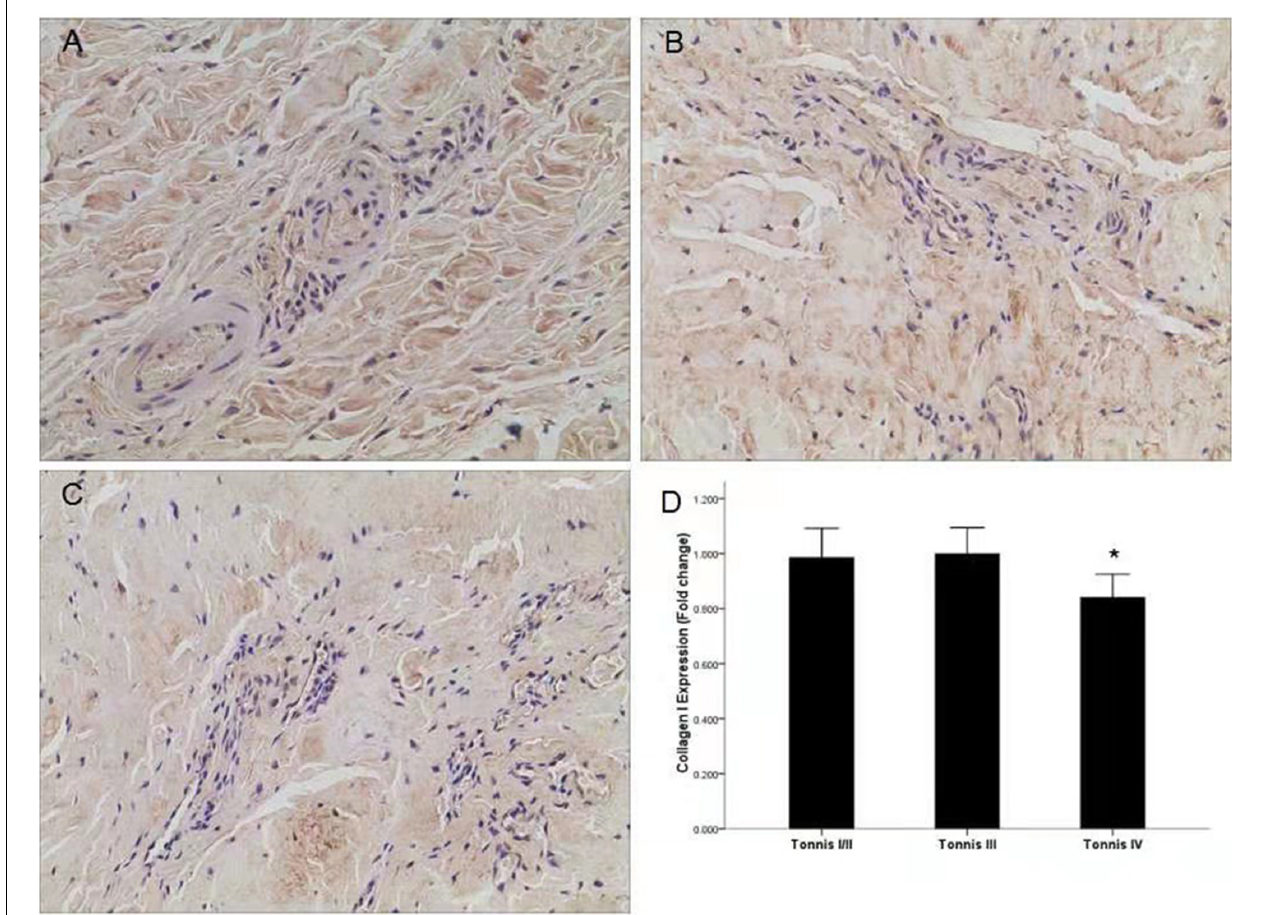
FIGURE 1 | Expression of collagen I in different groups according to the Tonnis classification. (A) Representative image of a Tonnis II grade DDH capsule. (B) Representative image of a Tonnis III grade DDH capsule. (C) Representative image of a Tonnis IV grade DDH capsule, and lower expression of collagen I was observed. (D) Quantification of collagen I immunohistochemistry results by measurement of the IOD in different groups. * P < 0.05; Magnification: 10 × 40.